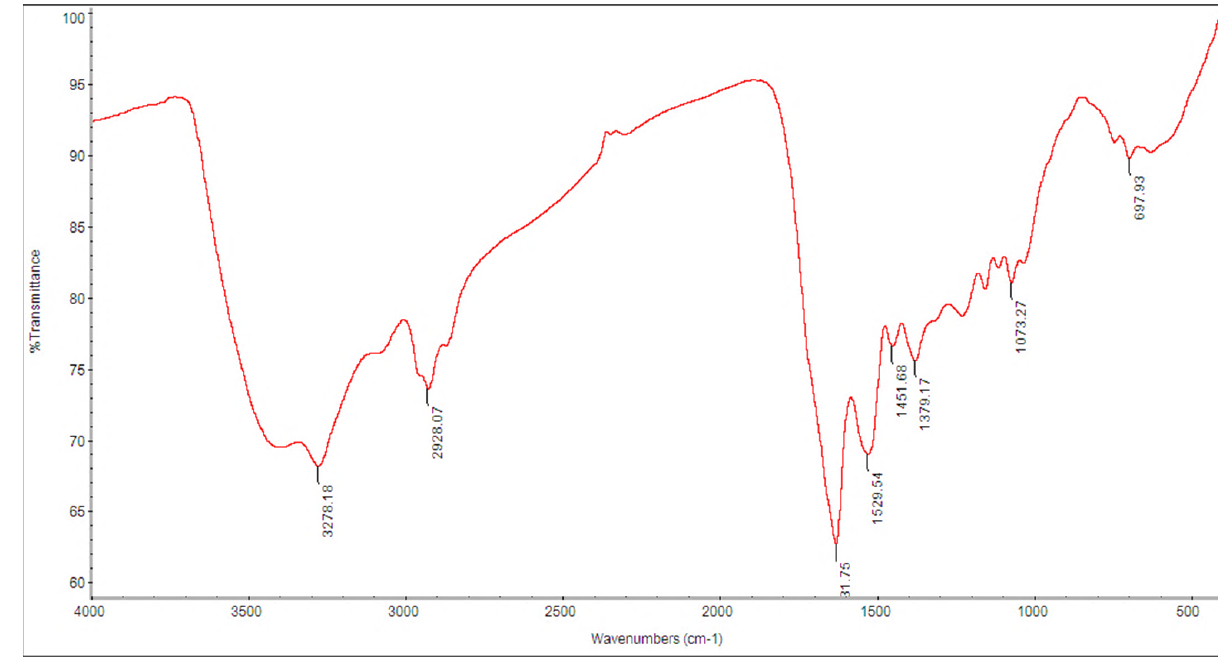
Figure 5. FT-IR spectrum of the melanin produced by G. oxydans FBFS 97.